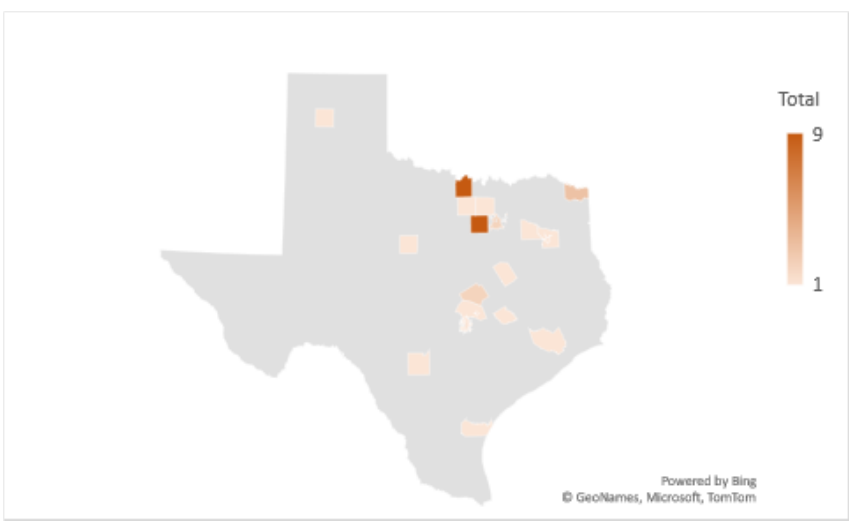
Figure 1. TTS respondent tick bite reports, total by county.